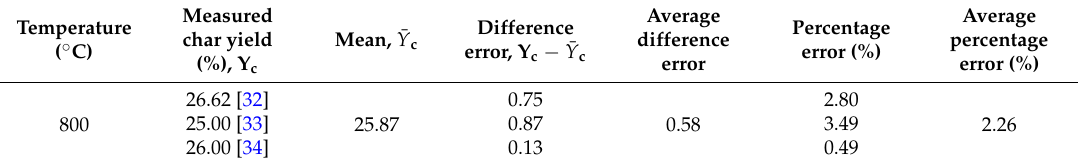
Table 4. Experimental error of three BA-a char yield measurements done by a “single” group study.